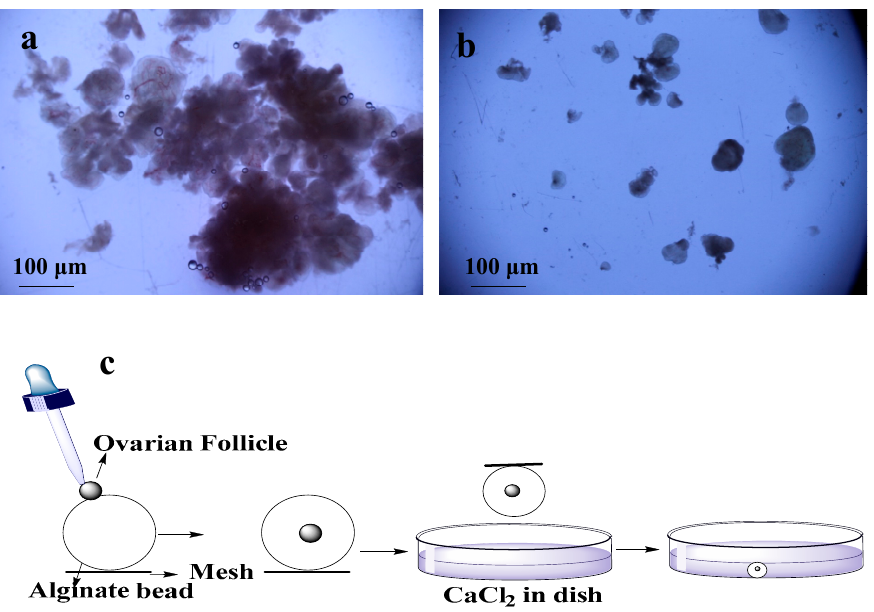
Figure 1. Isolation and encapsulation of ovarian follicles (OFs): ( a ) tissues used for enzymatic digestion for isolation of OFs; ( b ) mechanically isolated OFs; ( c ) encapsulation of OFs by using alginate bead and CaCl 2 .